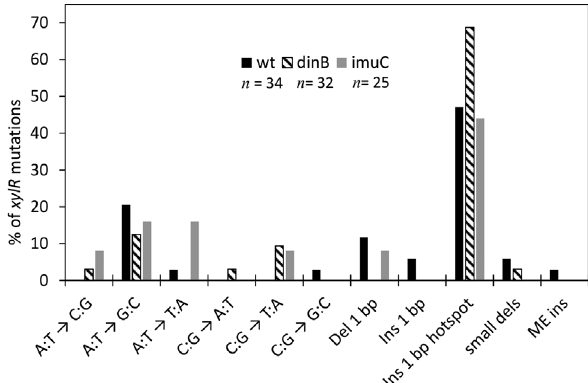
Figure 4 - Distribution of the different base substitutions in xylR in wt, dinB and imuC strains.Thedifferentbasesubstitutionsareindicated.Del1 bp: 1 bp deletions. Ins 1 bp: 1 bp insertions not located in the hotspot. Ins 1 bp hotspot: 1 bp insertions located in the hotspot. Small dels: 2-8 bp dele- tions. ME ins: insertion of mobile elements. n indicates the number of mu- tants analyzed in each